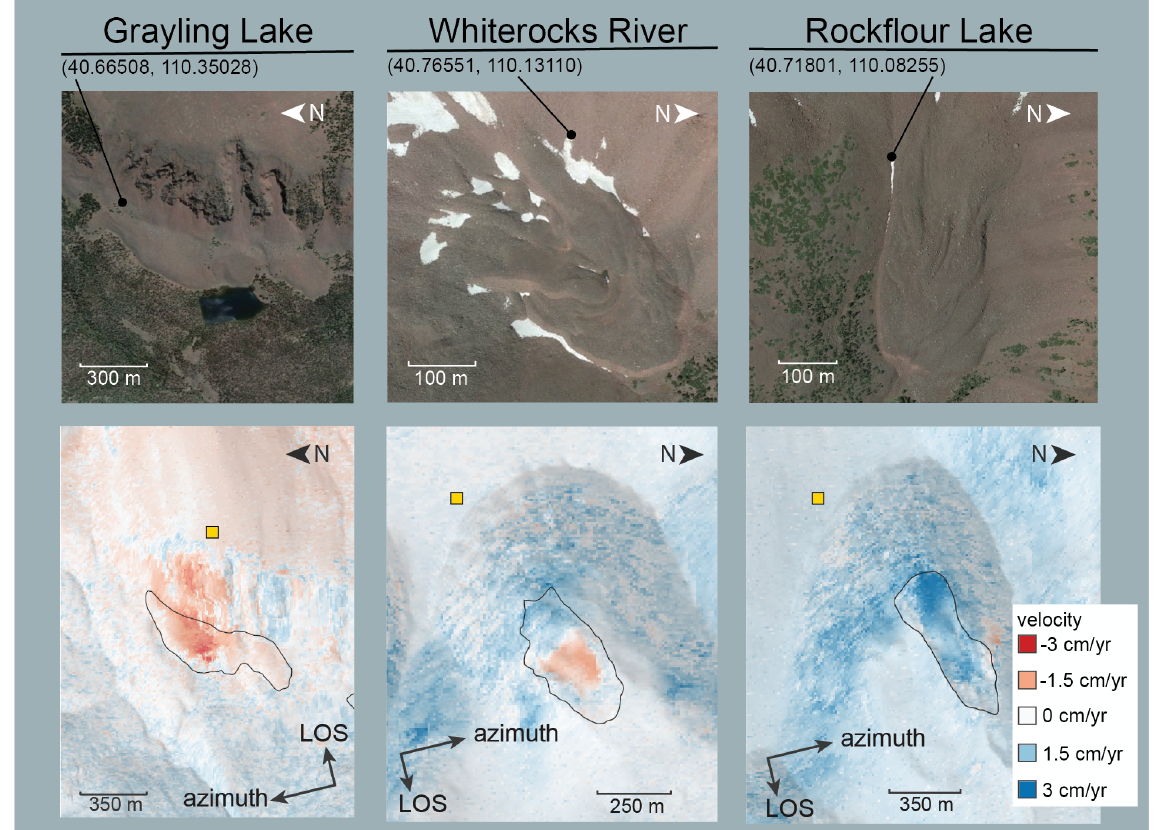
Figure 3. Individual rock glaciers investigated with time series. (Top) Overhead view of rock glaciers in © Google Earth, annotated in Adobe Illustrator. (Bottom) Average velocity stack draped over a hillshade. Rock glaciers were added to our active inventory if they displayed clear deformation signal, like those above. Yellow squares represent stable local reference points used in our time series